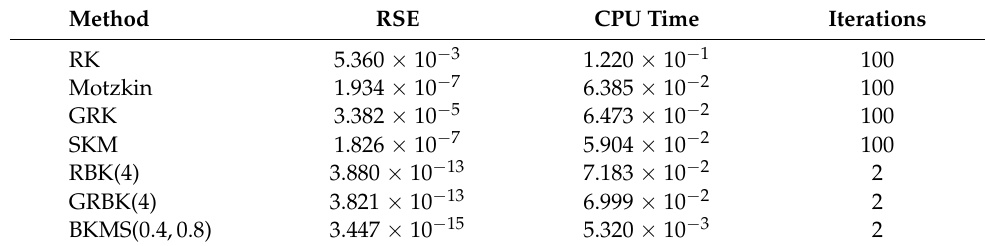
Table 5. Numerical results for the “ phillips ” test problem.